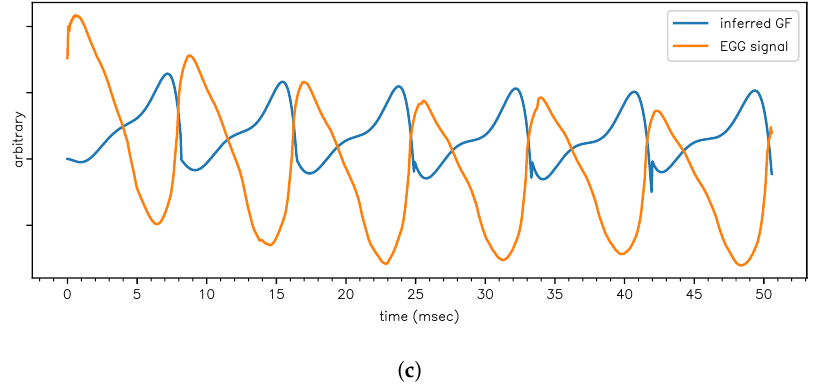
Figure 6. Application of the model ( P = 6, Q = 3 ) to a SSV / E / in order to estimate the frequency and decay constants of F1, F2, F3. ( a ) Fit to the data shown in Figure 4. ( b ) We can estimate the dGF waveform via the amplitudes ˆ A k , and integrating this estimate yields the glottal flow (GF) waveform. As an independent qualitative check, in this subplot the GF is compared to a GF obtained via inverse filtering [25]. ( c ) The estimated GF waveform (the same as in plot ( c )) is now compared to the EGG signal which was simultaneously recorded with the / E / waveform [22]. A high value of the EGG means that the glottis is closed, so the GF must be small. A low value of the EGG means that the glottis is open, and the GF should be big (as air from the lungs can escape outward). This anticorrelation is perfectly